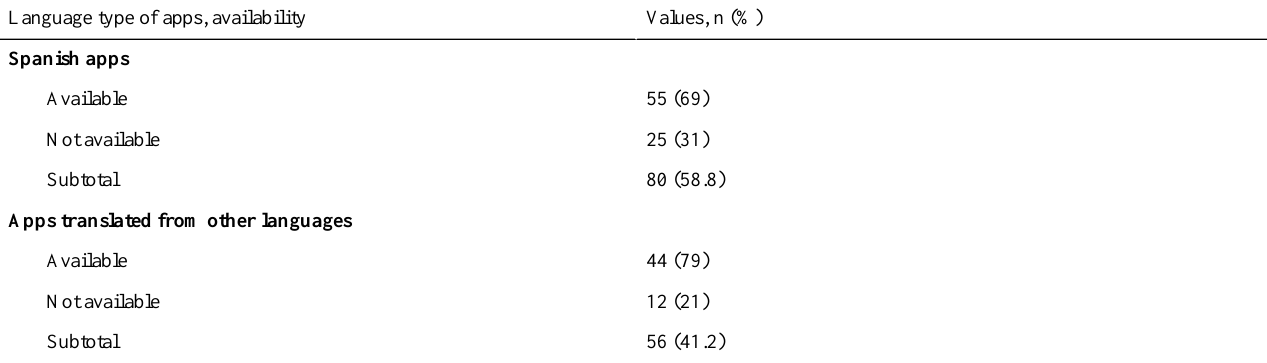
Table 6. Native Spanish apps and apps that were translated from other languages to Spanish (n=136).